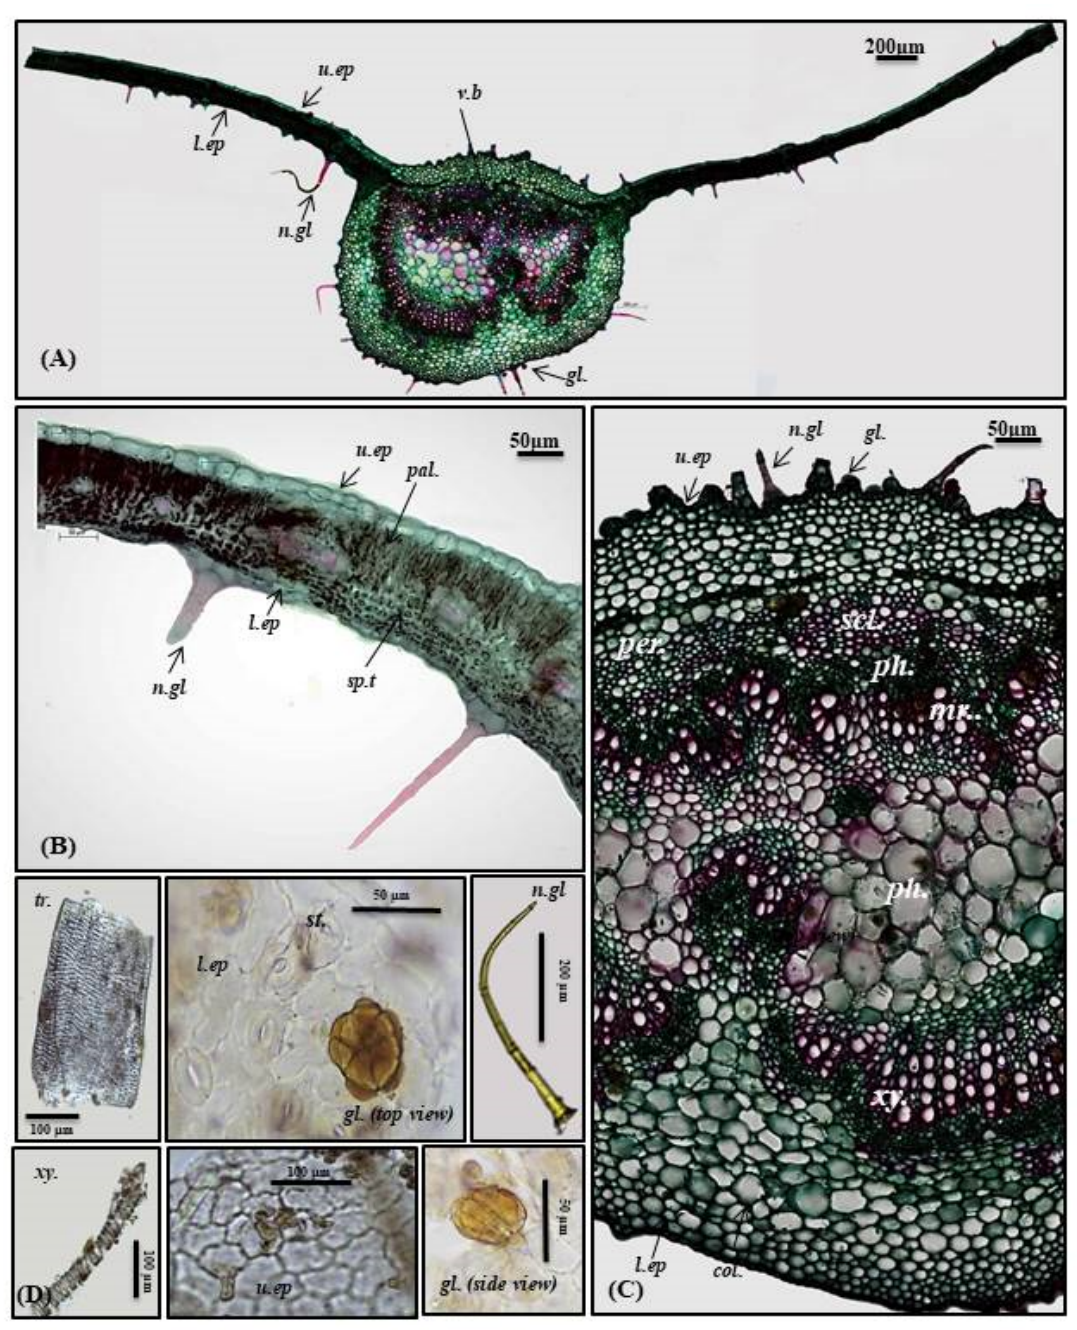
Figure 2. Micromorphology of P. odorata leaf showing ( A ) entire T.S (×100), ( B ) lamina (×400), ( C ) midrib region (×400), and ( D ) isolated elements. Col. , collenchyma; gl. , glandular peltate trichome; l.ep. , lower epidermis; Mr. , medullary rays; n.gl. , non-glandular trichome; pal. , palisade; per. , pericycle; ph. , phloem; scl. , sclerenchyma; sp.t. , spongy tissue; tr., tracheids; u.ep , upper epidermis; v.b., vascular bundle; xy ., xylem.